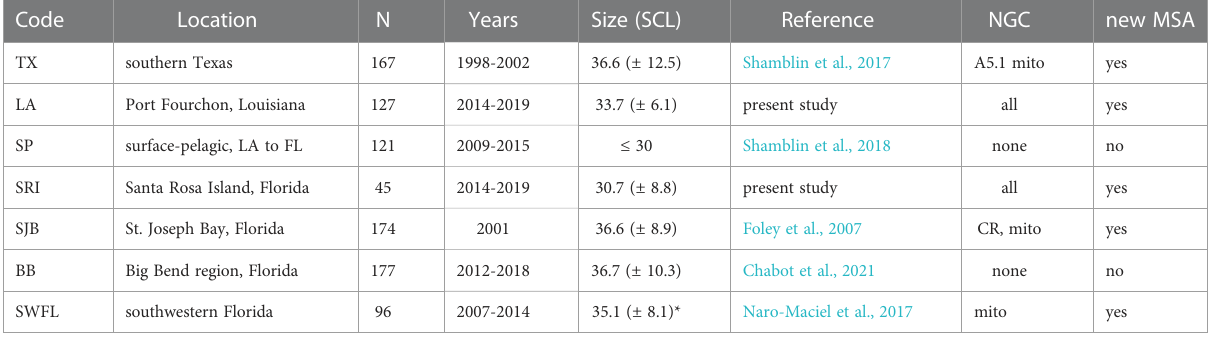
TABLE 1 Sampling locations and metadata for analyses of juvenile green turtle foraging aggregations in the Gulf of Mexico.